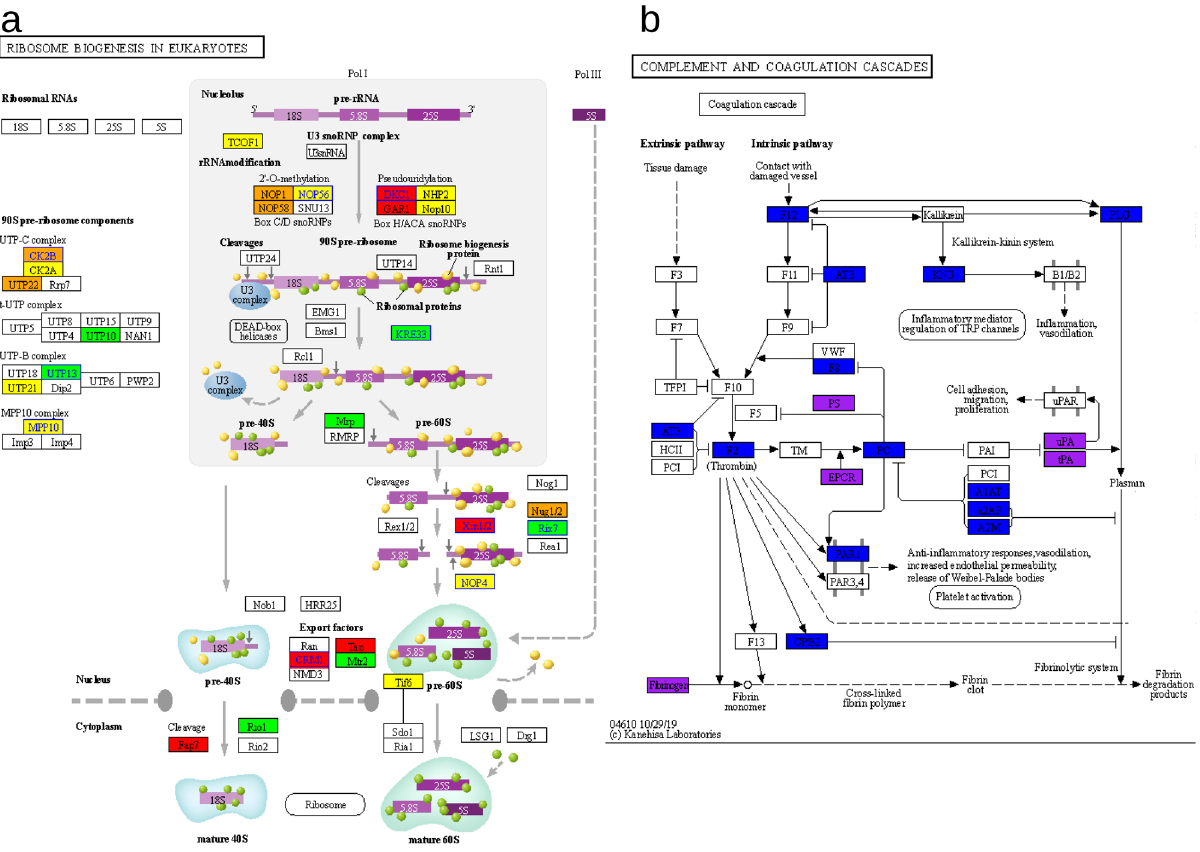
Figure 6. Signaling pathways KEGG 19 . ( a ) Signaling pathway for the synthesis of ribosomes in lung (pneumocytes), 10 proteins with direct interaction with name and line blue. 30 of 101 proteins are reported. The colors code associated to expression value was used. ( b ) Coagulation cascade and the 19 proteins (39 including those of the complement system) that can interact directly (purple), 6 proteins, or indirectly (blue), 13 proteins, with SARS-CoV-2 proteins in blood. Only the coagulation cascade is